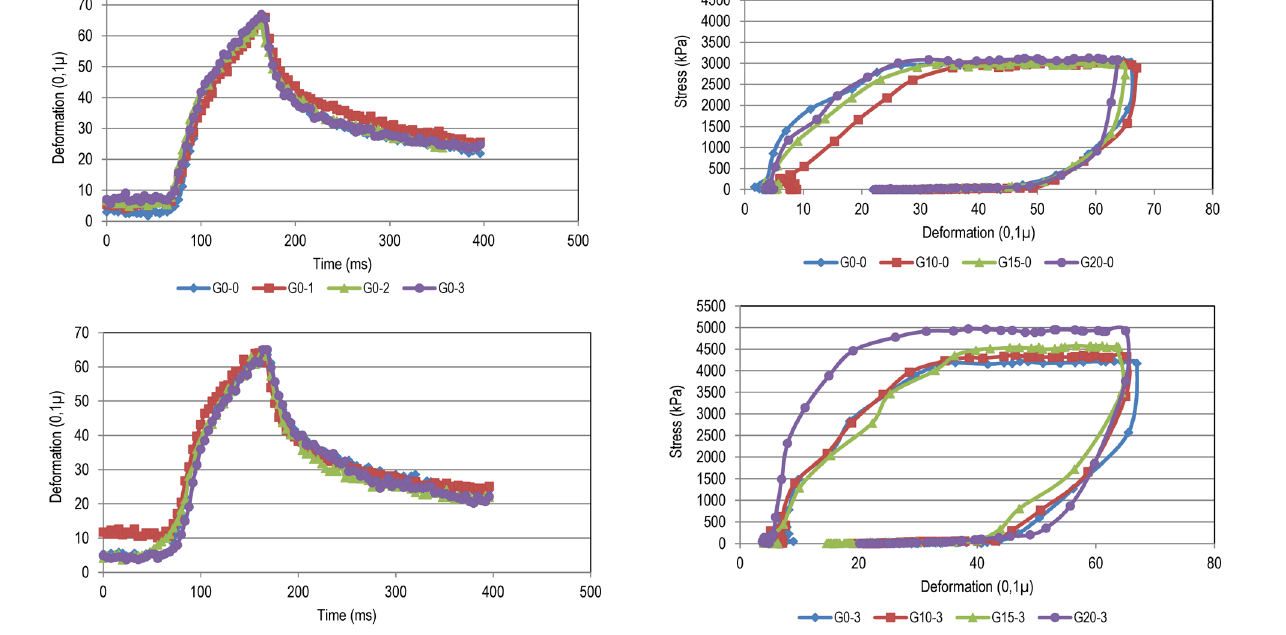
Fig. 5. The deformation-time relation of the asphalt mixtures